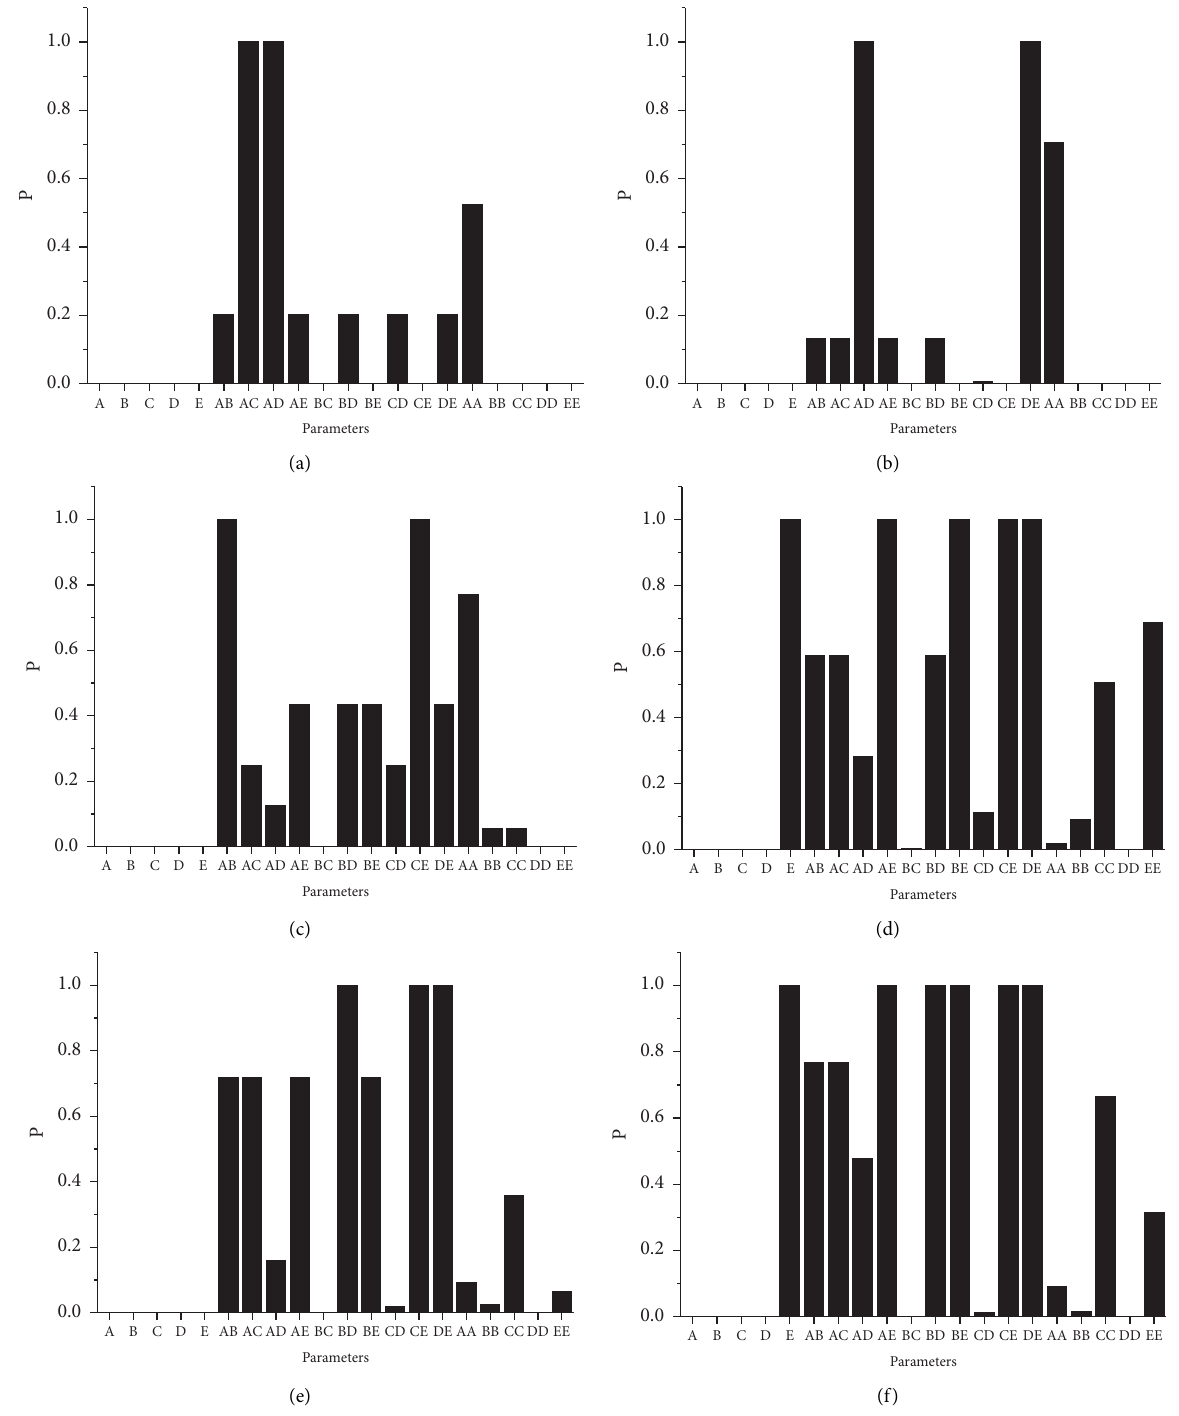
Figure 7: Signifcance of updating parameters for each order of frequency. (a) Signifcance of the updating parameter for the frst-order frequency. (b) Signifcance of updating parameters for second-natural frequencies. (c) Signifcance of the updating parameter for the third- order frequency. (d) Signifcance of the updating parameter for the fourth-order frequency. (e) Signifcance of the updating parameter for the ffth-order frequency. (f) Signifcance of the updating parameter for the sixth-order